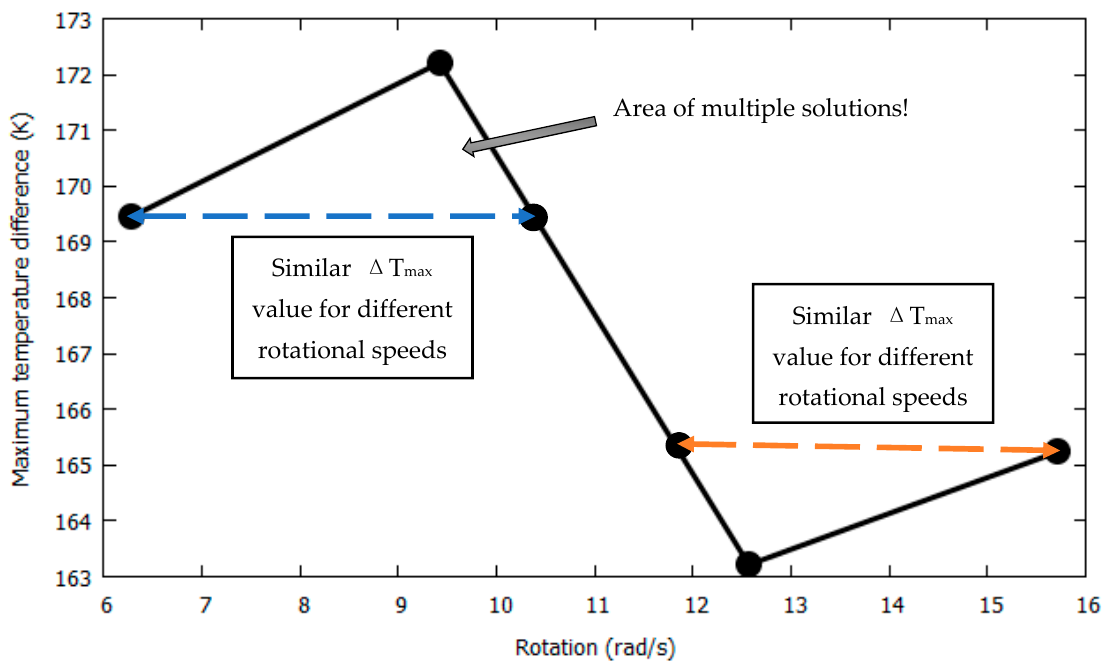
Figure 11. Δ T max w.r.t rotation at 3g with a distance of 0.1433 cm between heater and sensors. Figure 11. ∆ T max w.r.t rotation at 3g with a distance of 0.1433 cm between heater and